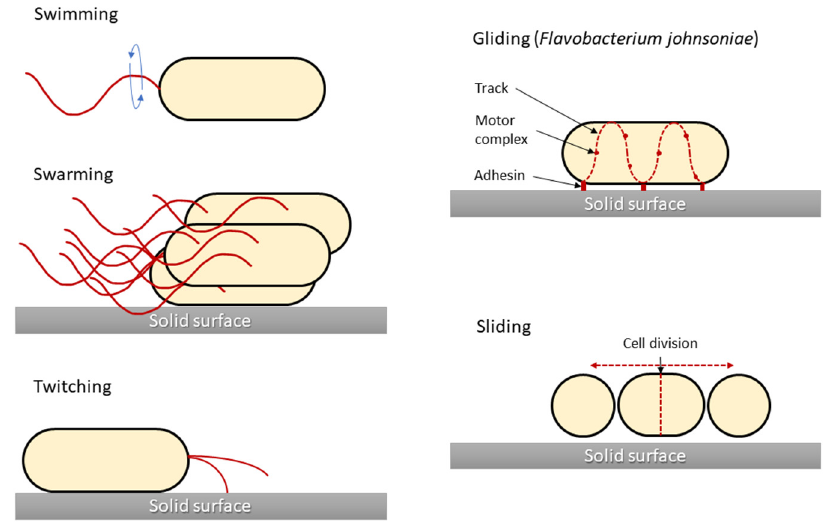
Figure 1. Graphical presentation of five bacterial movement types. Structures responsible for generating bacterial movement are marked in red. Sliding motility is presented for Flavobacterium johnsoniae as a model for this type of motility, although for other bacteria (i.e., Myxococcus xanthus ) there are differences in the cell propulsion mechanism. The figure was prepared based on the data and figures presented in [31].